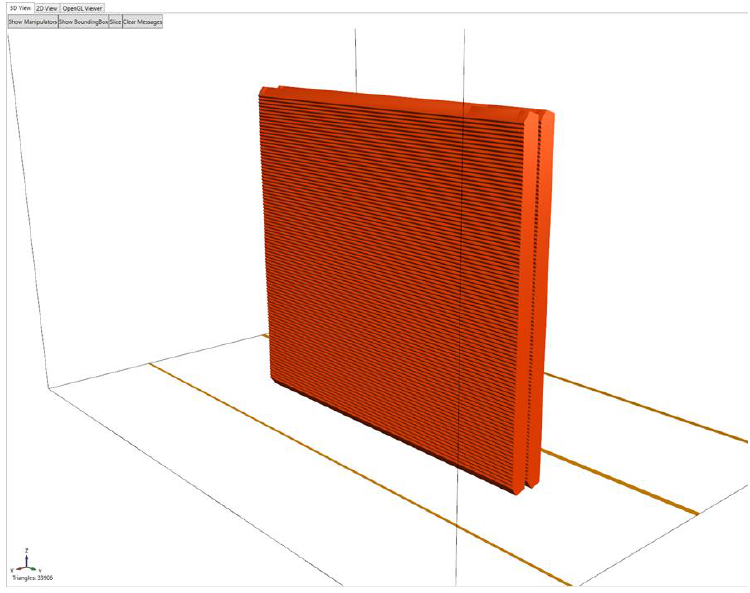
Figure 4 . Double-bead wall in ORNL Slicer environment. Figure 4. Double-bead wall in ORNL Slicer